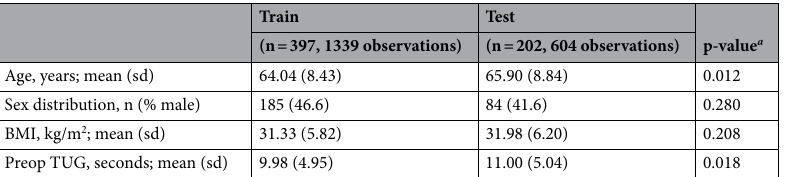
Selection of matches by predictive mean matching. Because the source datasets contained TUG